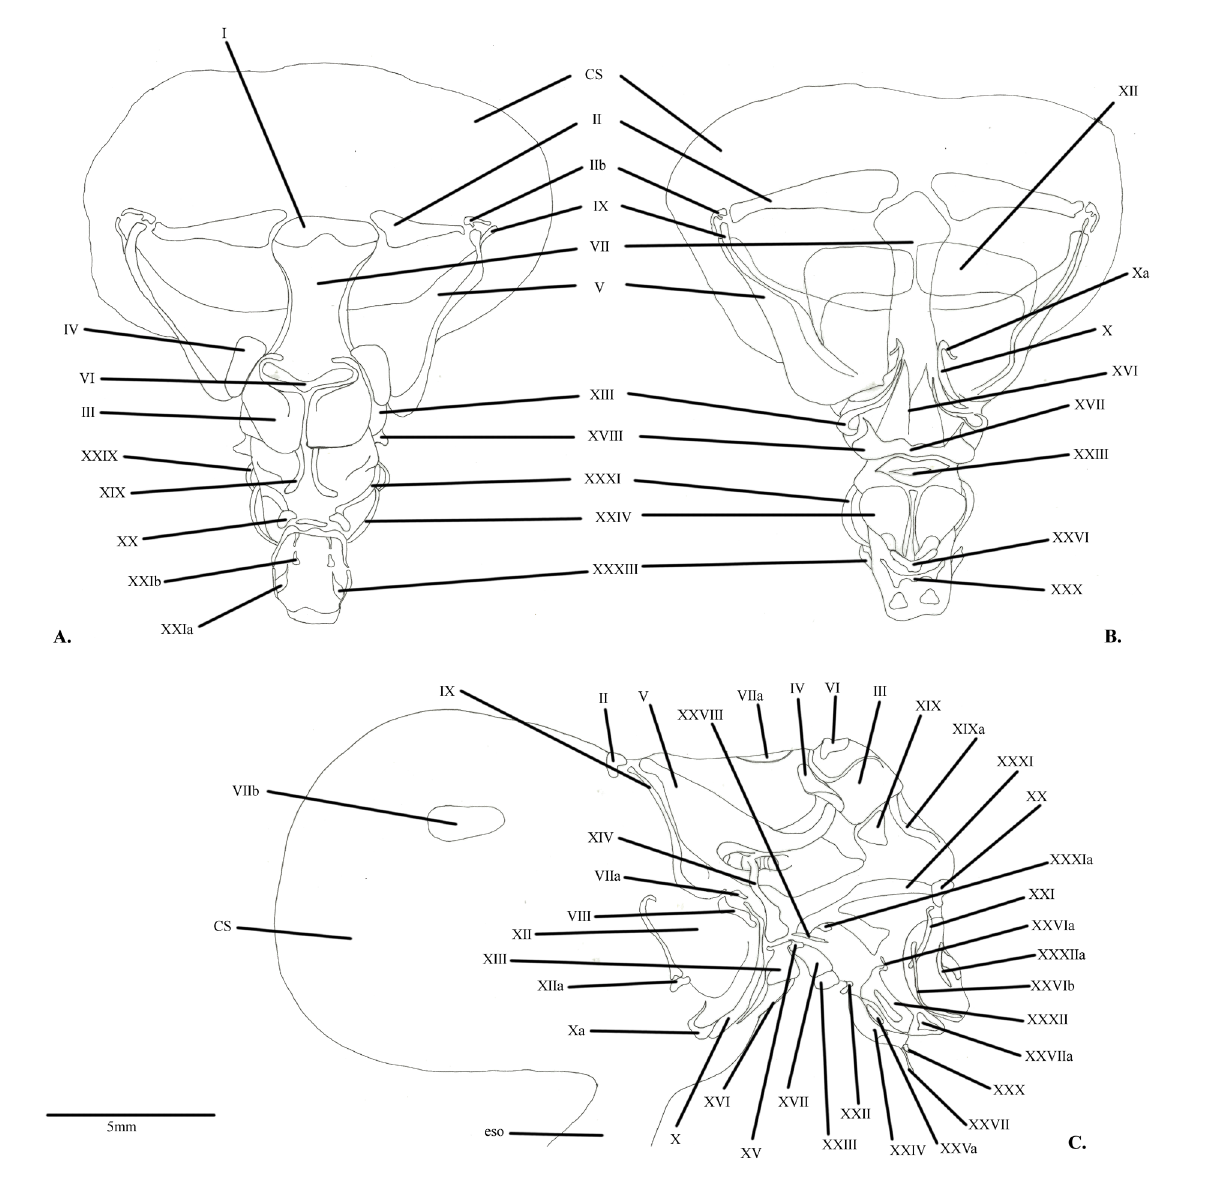
Figure 2. Dilocarcinus septemdentatus (Herbst, 1783), cardiac and pyloric chambers of the foregut. A, Dorsal view; B, ventral view; C, lateral view. Abbreviations: CS, cardiac sac; eso, esophagus; see Tab. 2 for the nomenclature of the